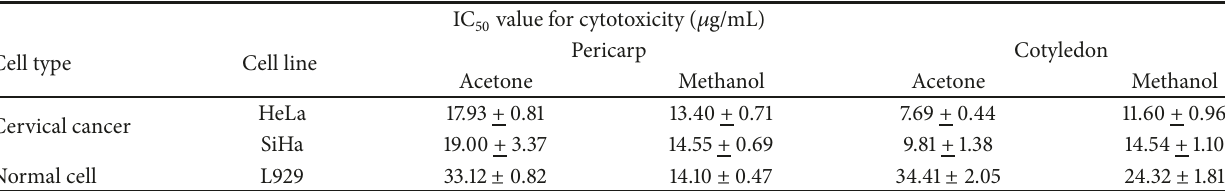
Table 1: The IC 50 of crude extracts isolated from VDS fruit type SS.